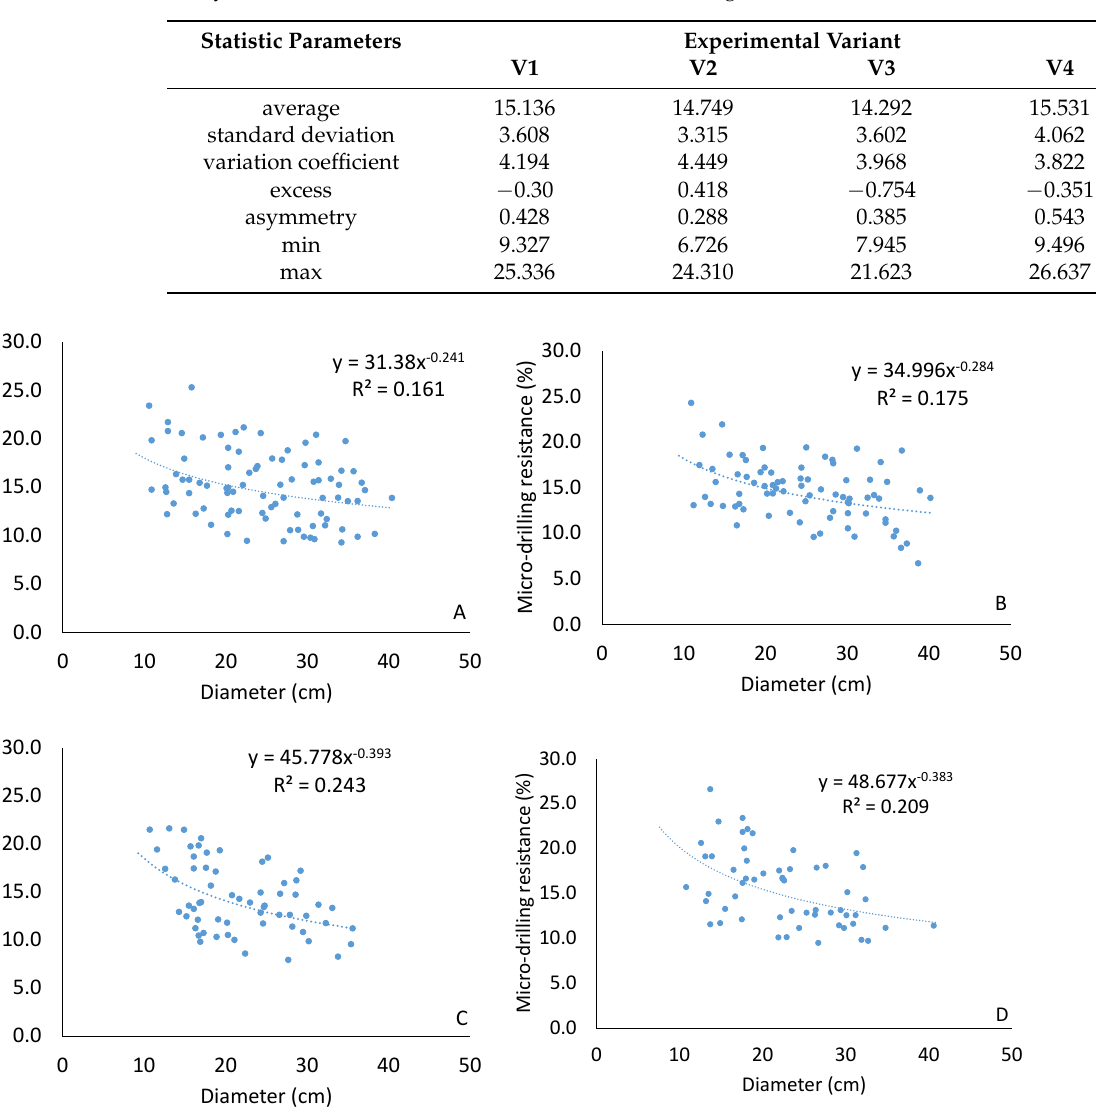
diameter. The disposition of density in relation to the diameter for V1 and V2